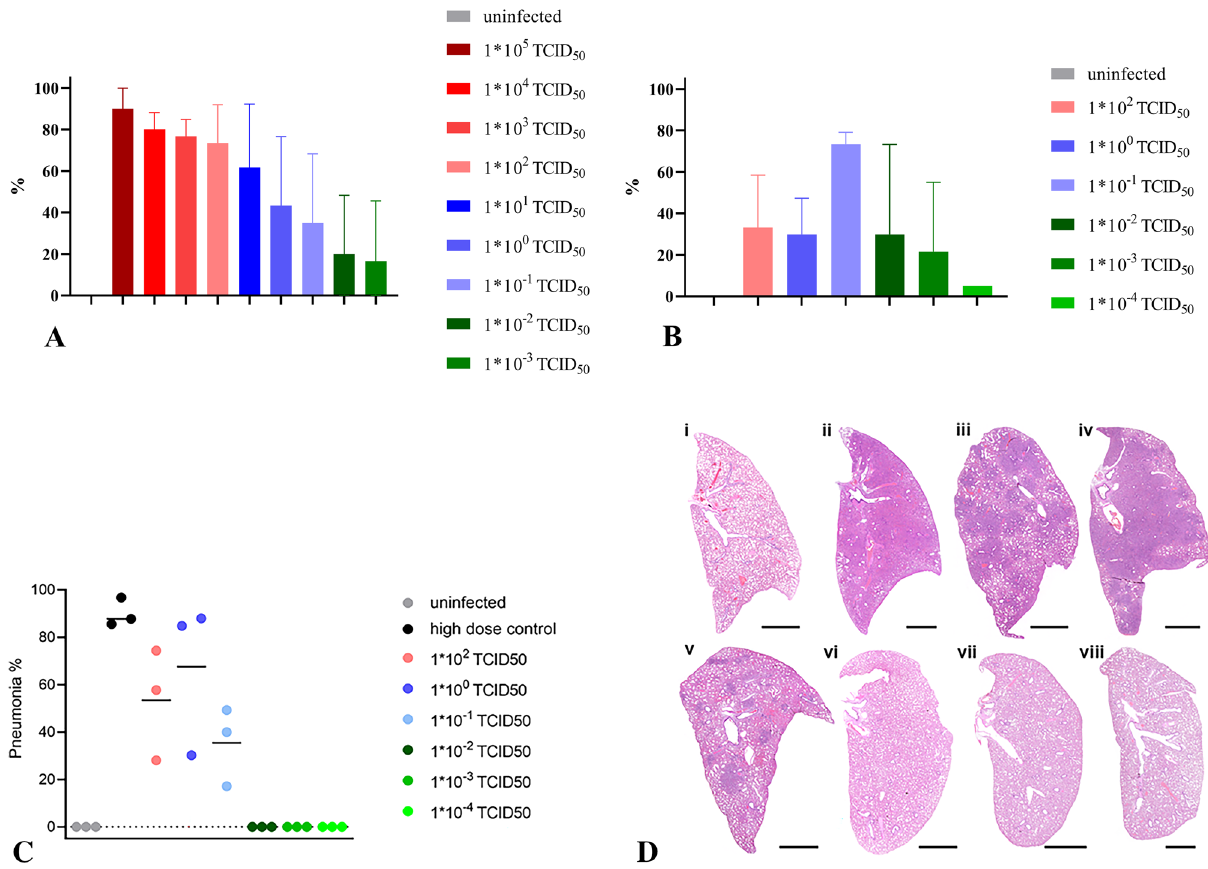
Figure 3. Levels of lung affection after challenge with different infection doses. ( A ) Macroscopically determined level of lesion-affection (%) of whole lung during autopsy at 7 dpi and ( B ) at 10 dpi displayed as the mean value and standard deviation for each group. ( C , D ) Histopathology of hamster lungs, 10 days after orotracheal SARS-CoV-2 infection. Pneumonia-associated consolidation ( C ) and representative overviews ( D ) of the entire left lung lobe of (i) uninfected control; (ii) high dose control; (iii) infected with 1 * 10 2 TCID 50 ; (iv) infected with 1 * 10 0 TCID 50 ; (v) infected with 1 * 10 −1 TCID 50 ; (vi) infected with 1 * 10 −2 TCID 50 ; (vii)